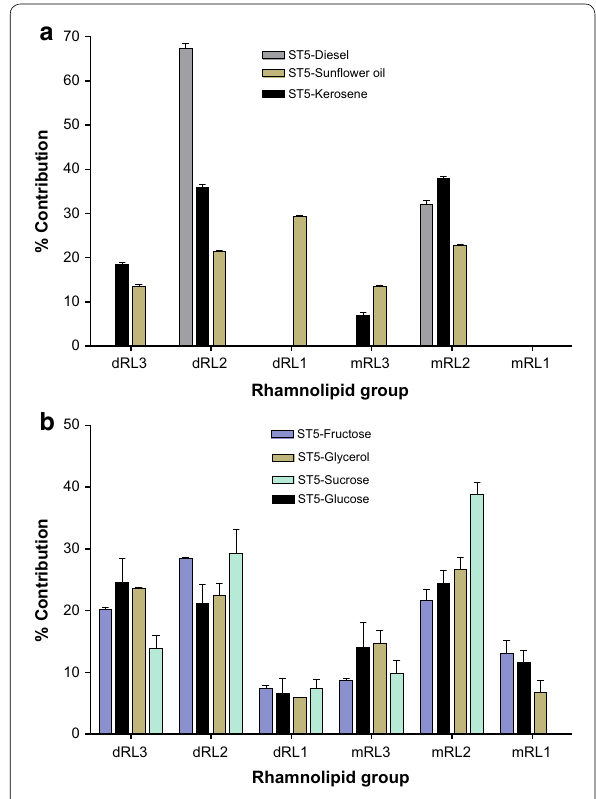
Fig. 4 Comparison of the extracts obtained from ST5 cultivated in mineral salt medium supplemented with a water immiscible substrates and b water miscible substrates, showing the relative contribution of each of the rhamnolipid groups in the biosurfactant extracts. The contribution was calculated from UPLC profiles, with the assumption that all the rhamnolipid species have similar ion